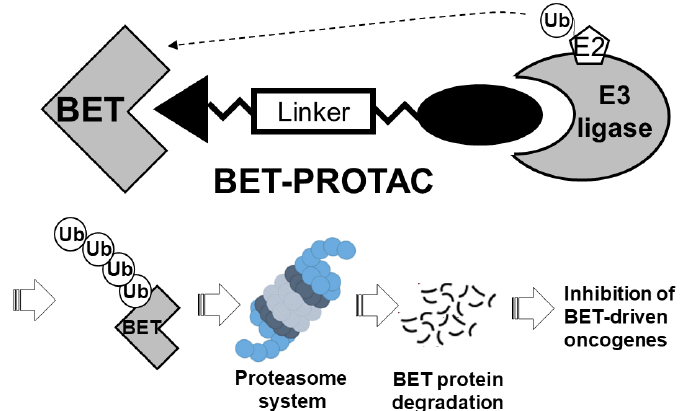
Figure 3. Schematic diagram showing the general design of a BET-protein-targeting proteolysis- targeting chimera (PROTAC). A typical PROTAC consists of a BET ligand connected to an E3 ligand via a linker. BET protein is brought to close proximity to the E3 ligase in the presence of the PROTAC, which is subsequently ubiquitinated (Ub) and subjected to rapid degradation.